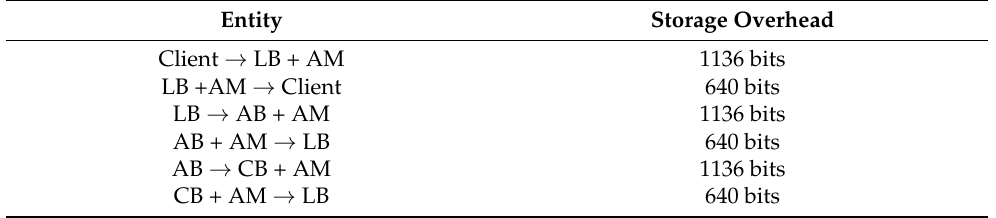
Table 6. Communication